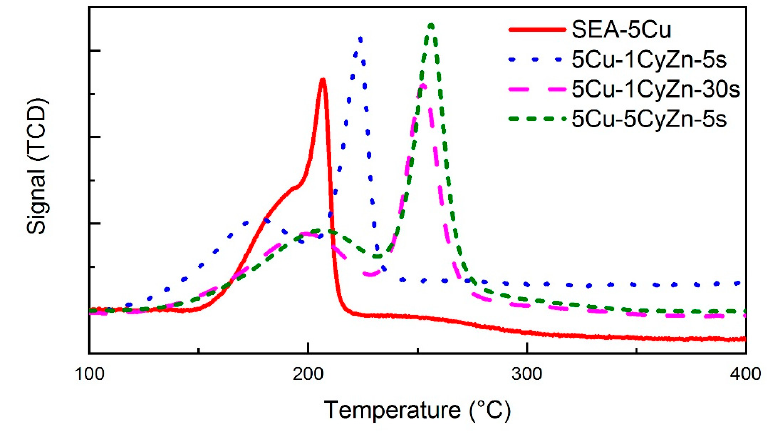
Figure 4. H 2 -TPR profiles of SEA-5Cu and ZnO over-coated Cu / SiO 2